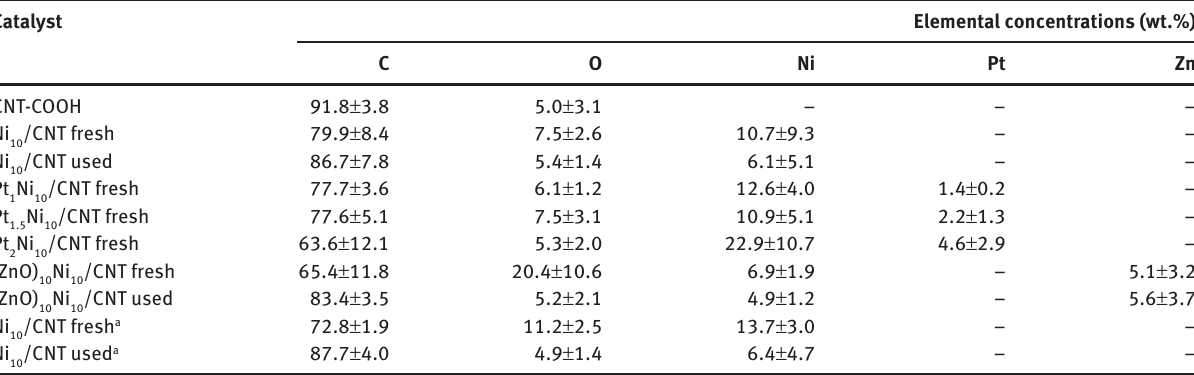
Table 2: The metal content by energy dispersive X-ray spectroscopy (EDX) analysis of fresh and used carbon nanotube (CNT)-supported catalysts.